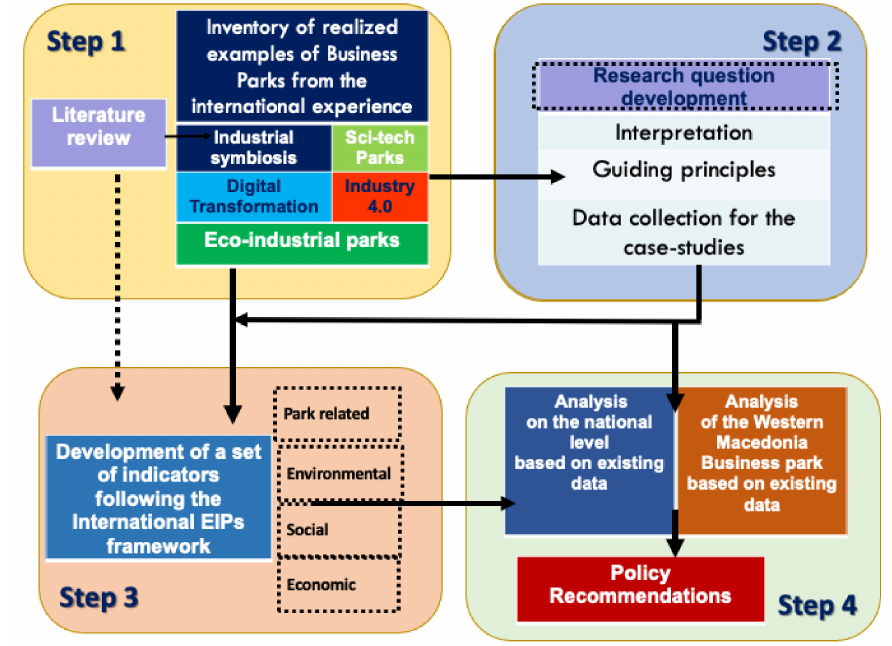
Figure 1. The research methodology. Source : Own elaboration by